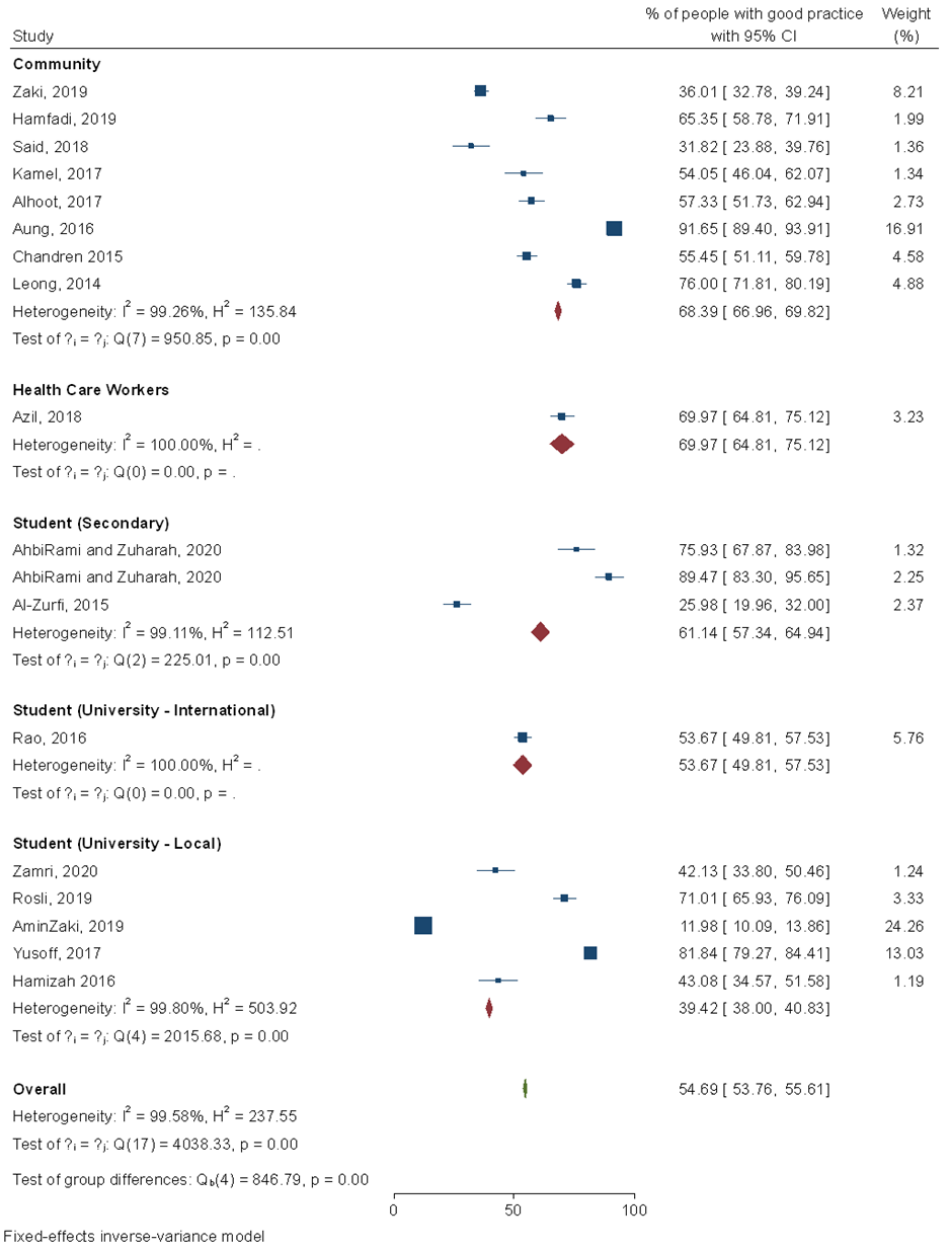
Figure 6. Meta-analysis of dengue practice score in Malaysia. Note: I 2 estimates the proportion of variation between the effect sizes due to heterogeneity relative to the pure sampling variation; I 2 > 50 indicates substantial heterogeneity; H 2 = 1 indicates perfect homogeneity among the studies; Q statistic is the weighted sum of squared differences between the observed effects and the weighted average effect.